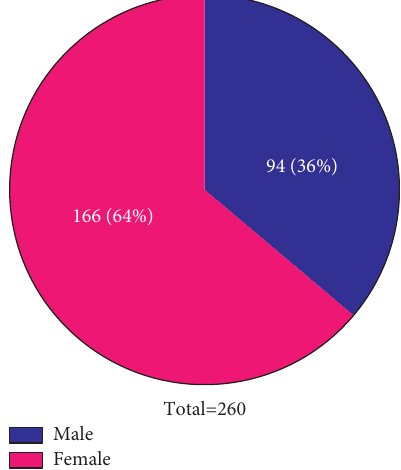
Figure 1: Gender composition. In the pie chart, blue represents men and red represents women. White font represents the number and percentage of each part.